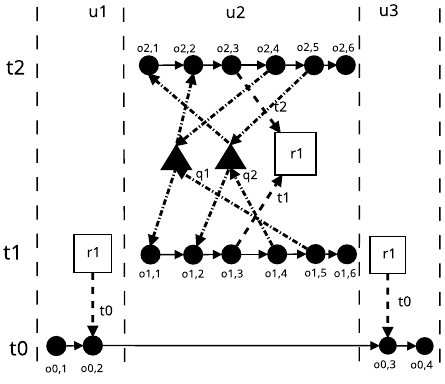
Figure 3. DL0 application operation